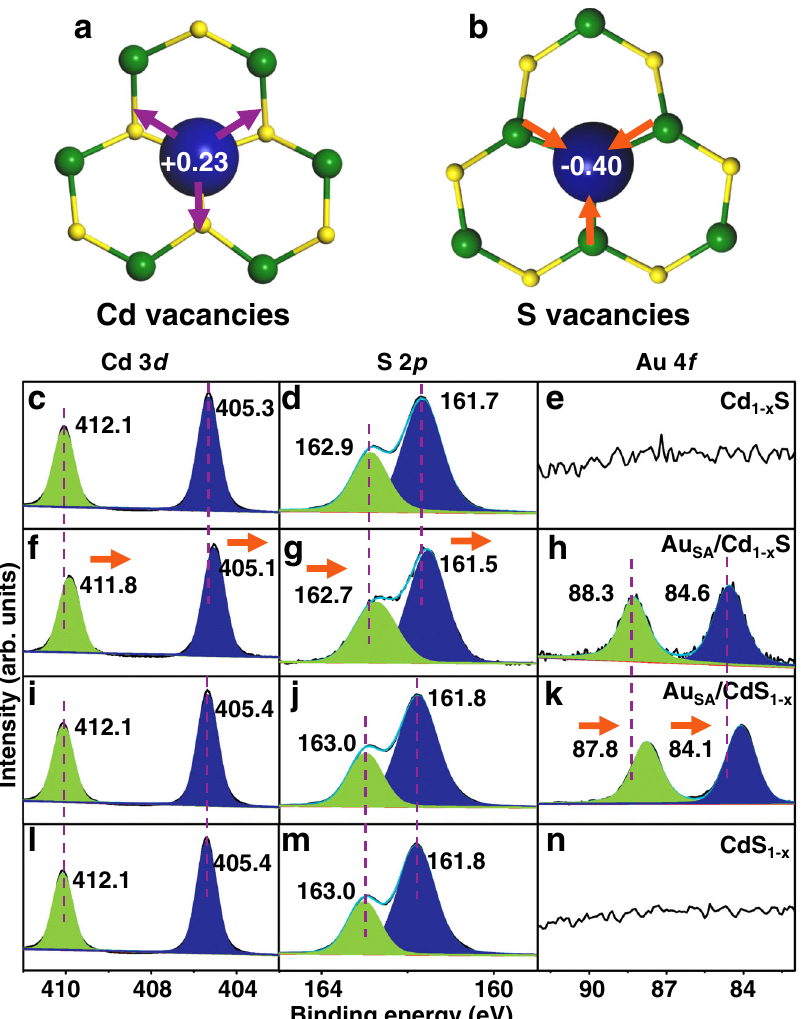
Fig. 6 Charge transfer on different surfaces. Electron transfer between Au and CdS with different types of vacancies: a Cd vacancies; b S vacancies. XPS spectra: c – e Cd 1-x S; f – h Au SA /Cd 1-x S; i – k CdS 1-x ; l – n Au SA /CdS 1-x